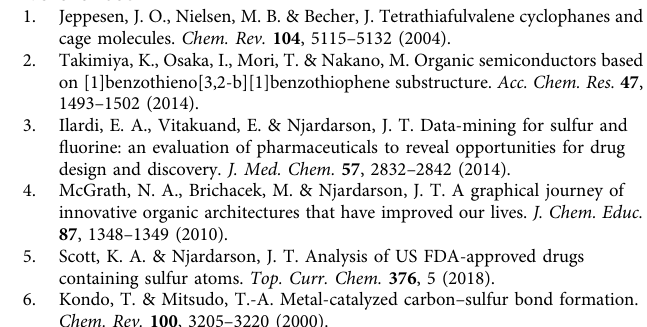
Fig. 9 The catalytic cycle. Proposed mechanism for remote hydrothiolation.